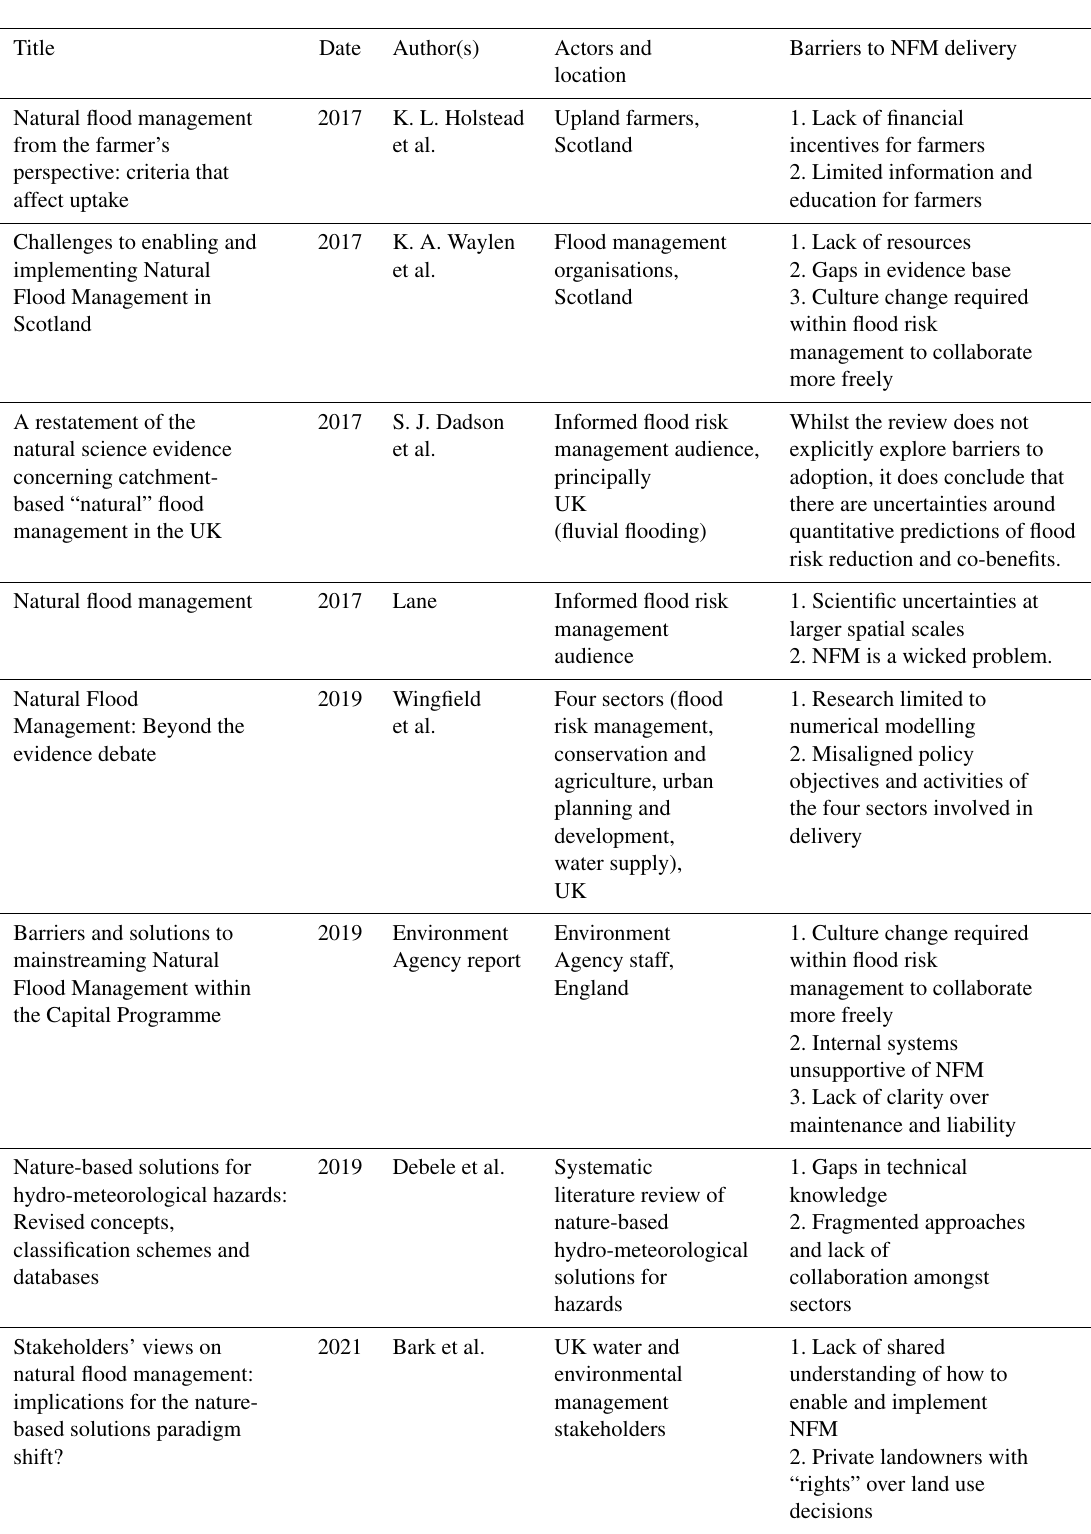
Table 1. Selection of published papers and reports identifying perceived barriers to NFM